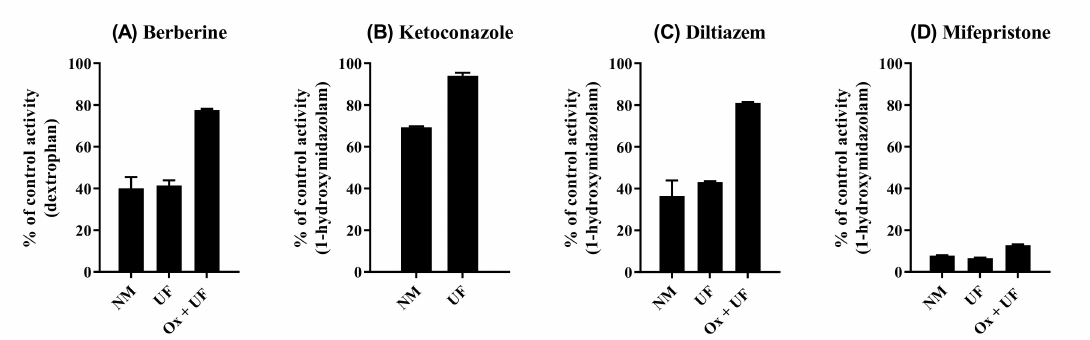
Figure 5. Reversibility of CYP inhibition by BBR ( A ), ketoconazole (( B )—a reversible inhibitor for CYP3A4), diltiazem (( C )—a quasi-irreversible inhibitor for CYP3A4), and mifepristone (( D )—an